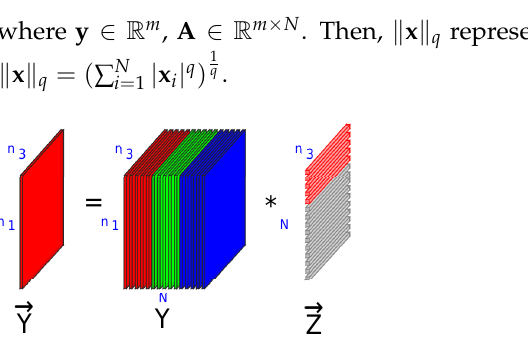
Figure 1. Self-expressiveness property of free submodules. Red fibers represent non-zero fibers and greyish fibers represent zero value fibers. Non-zero fibers represent coefficients from intra-cluster.